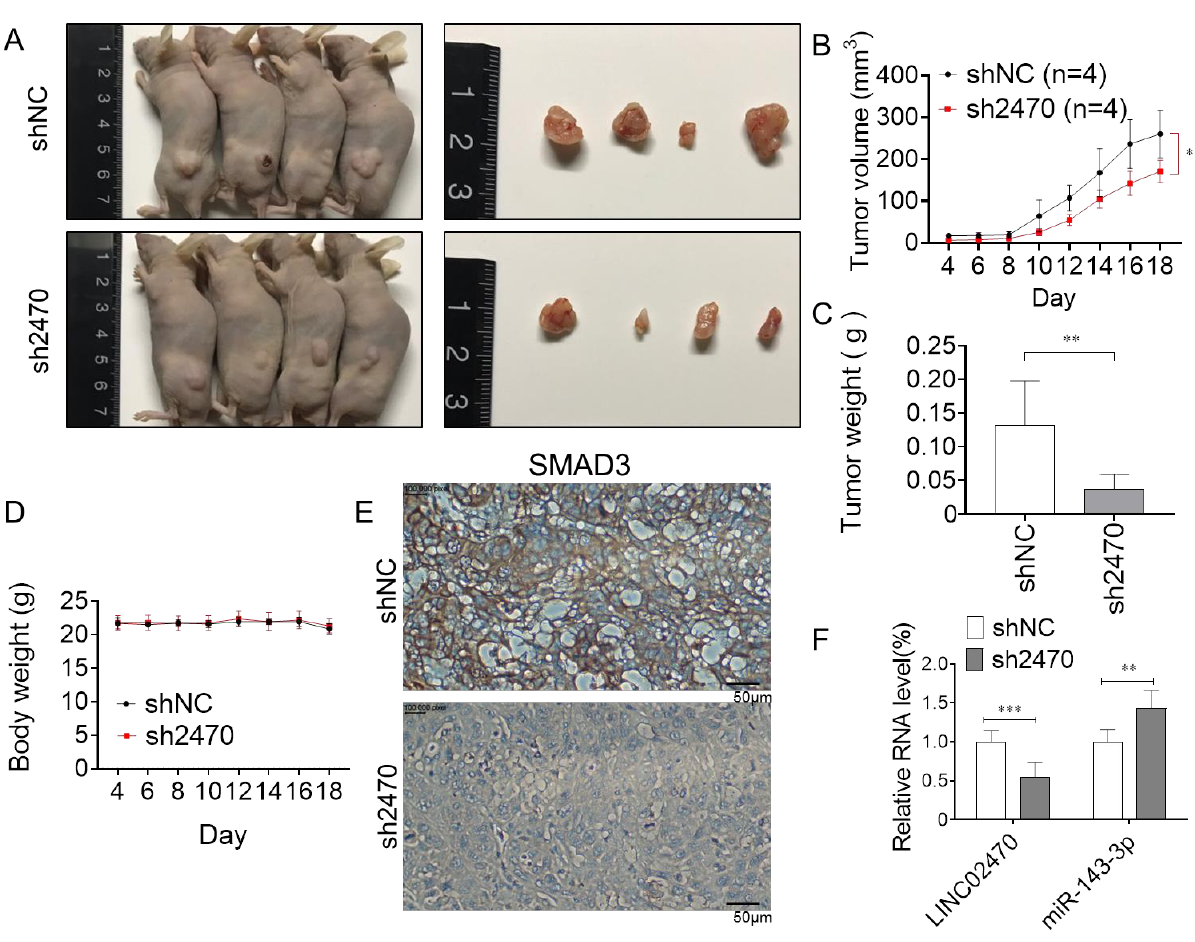
Figure 6. The effect of LINC02470 on the tumorigenicity of bladder cancer cells (T24 cells). ( A ) Representative xenograft tumors and dissected tumor masses of shLINC02470 (sh2470)- and shRNA negative control vector (shNC)-transfected T24 cells are shown. ( B ) Tumor volumes in the sh2470 and shNC group were measured for 18 days, and shLINC02470 reduced the tumor growth rate. ( C ) Tumor weights of tumor masses dissected from the sh2470 and shNC groups were measured. ( D ) Mouse body weight was also measured for 18 days, and sh2470 and shNC did not affect body weight. ( E ) Representative IHC results showing SMAD3 expression in xenograft tumor specimens in the sh2470 and shNC group. ( F ) Relative RNA levels of LINC02470 and miR-143-3p were compared between the sh2470 and shNC groups via RT-qPCR or stem-loop RT-qPCR (* p < 0.05, ** p < 0.01, *** p < 0.001, Student’s t -test).